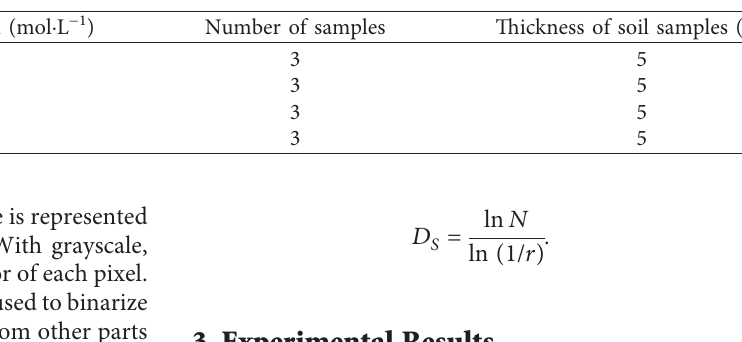
Table 2: Experimental